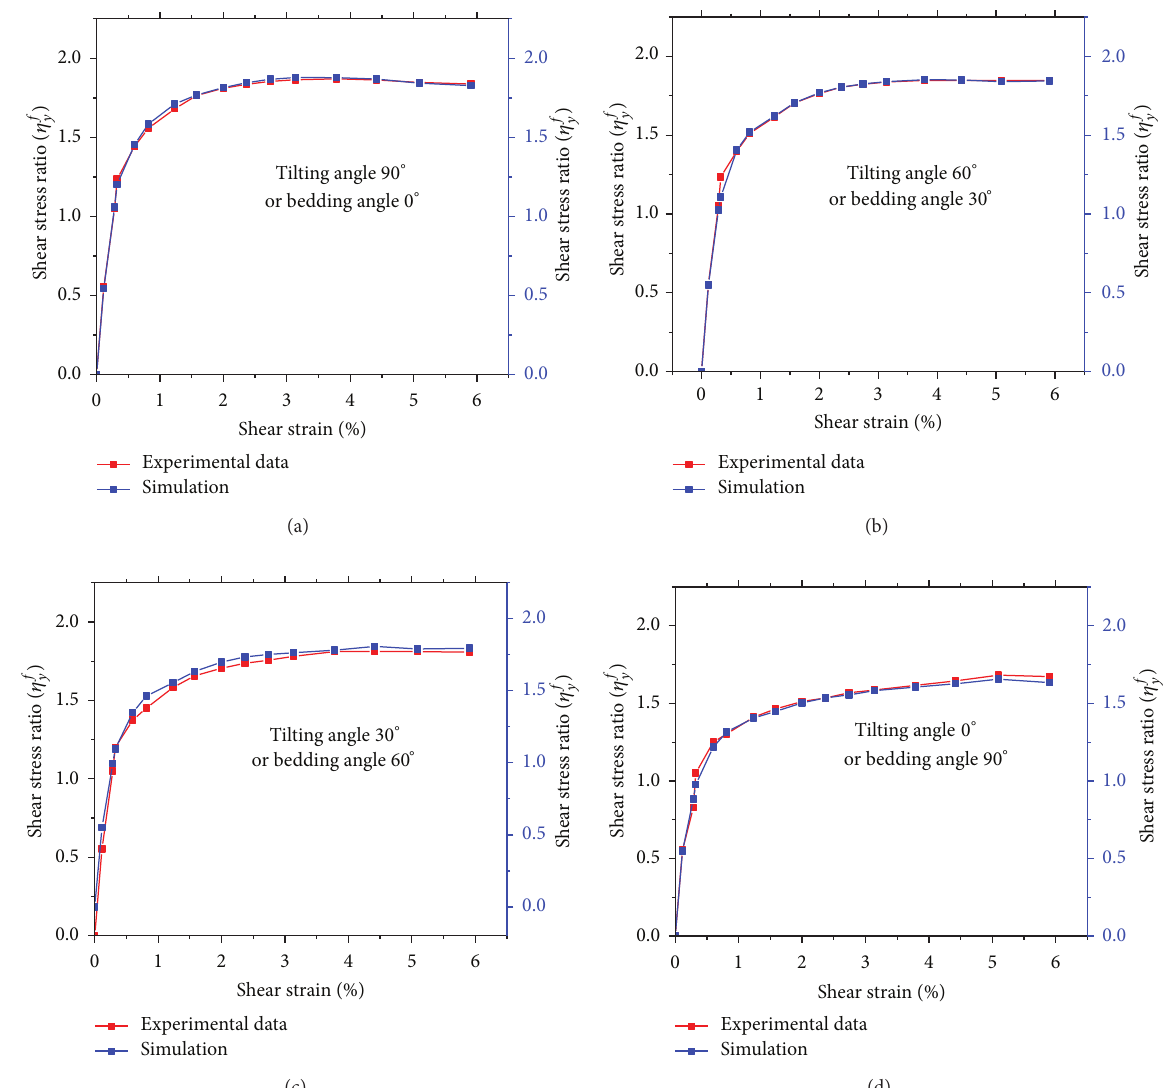
Figure 2: Comparison between experimental data and simulation by using (16) for the confining pressure 0.5kg/cm 2